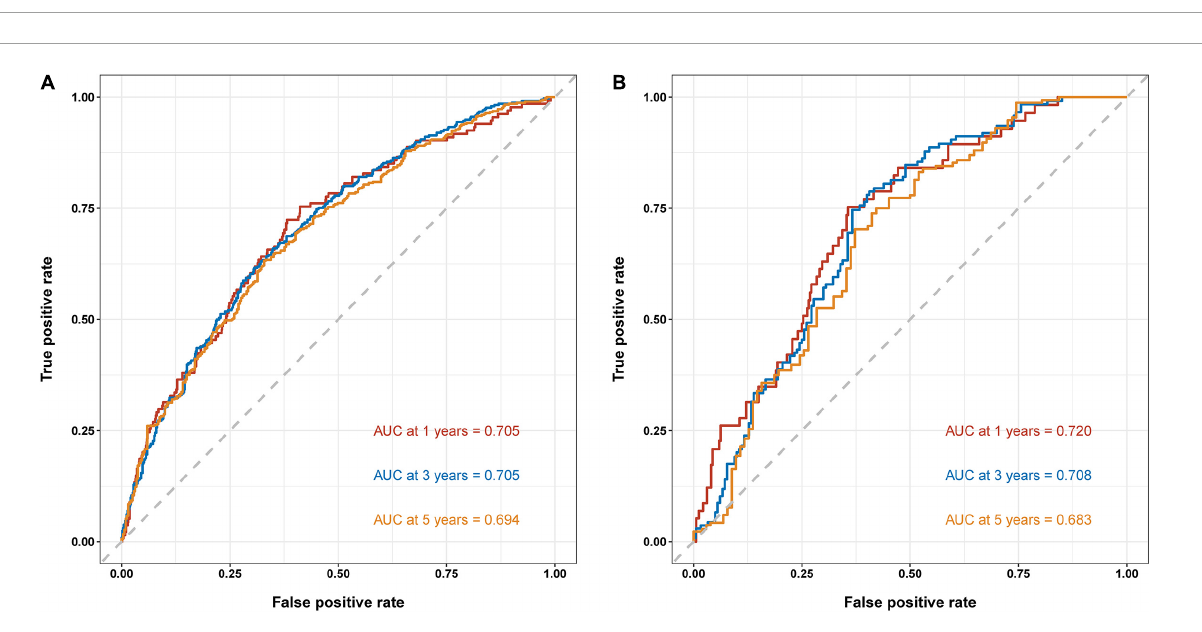
FIGURE4 Time-dependent receiver operating curve (ROC) analysis of nomogram model. (A) Training set. (B) Validation set.